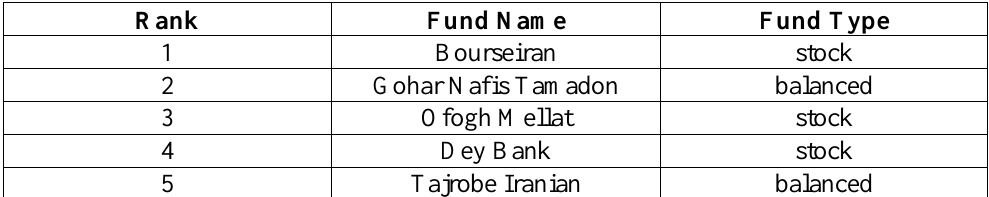
Table 4. Five Systemically Important Funds in the Year Leading to Late September 2019